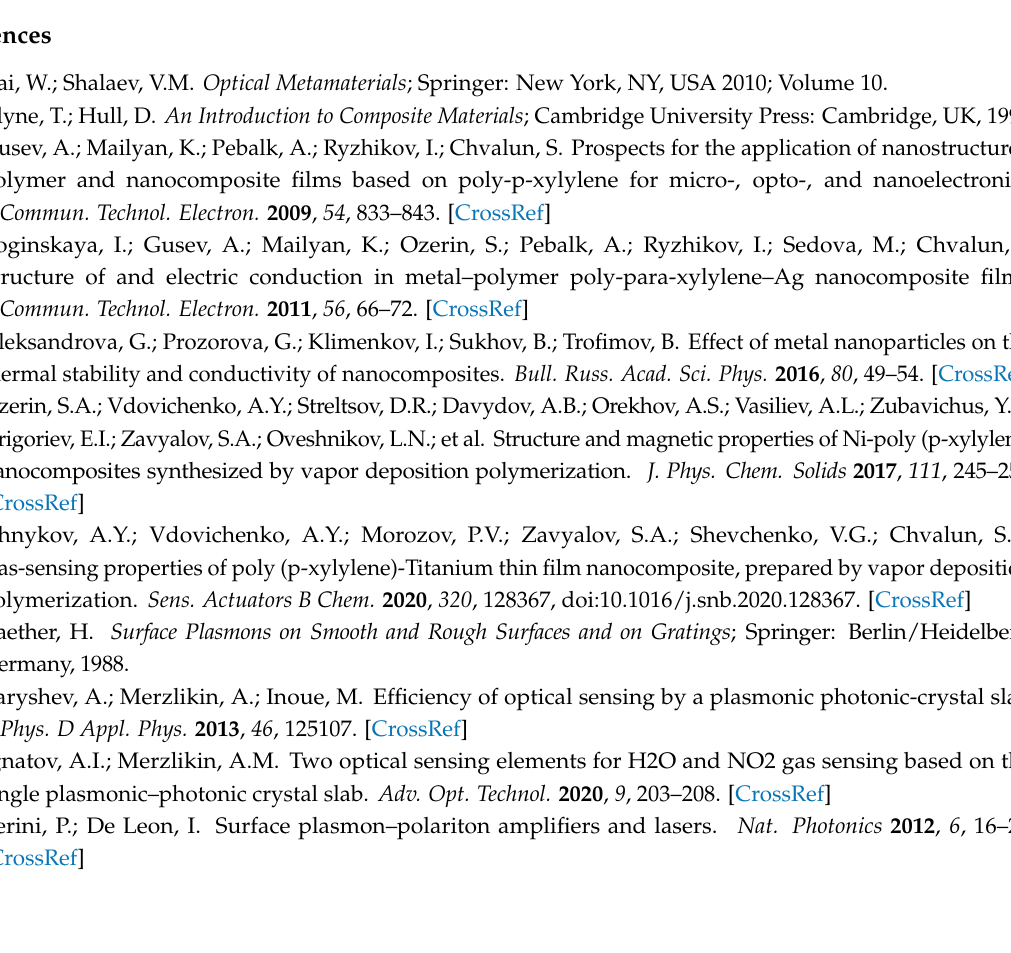
Figure S1: The thermogravimetric measurements of PPX+Ag coatings with different concentrations of silver in nitrogene